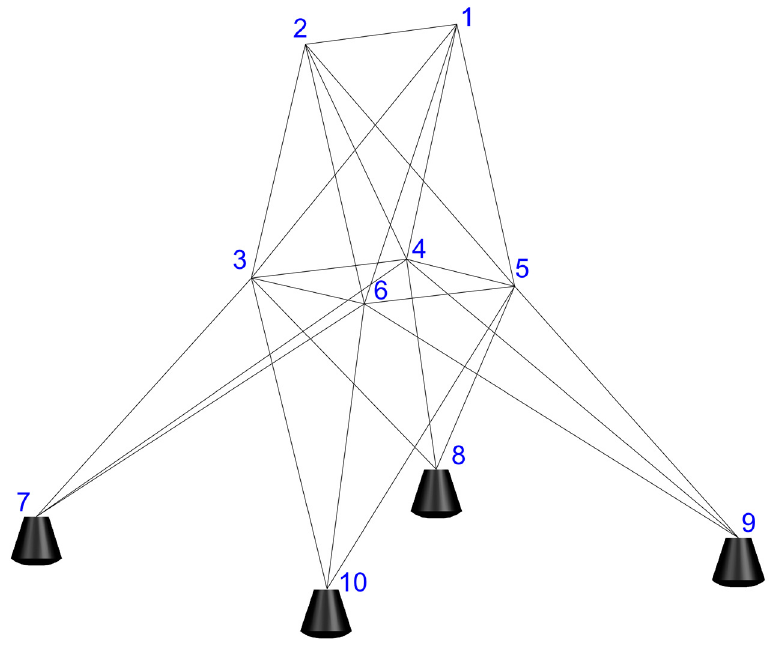
Figure 19. The 25-bar spatial truss.